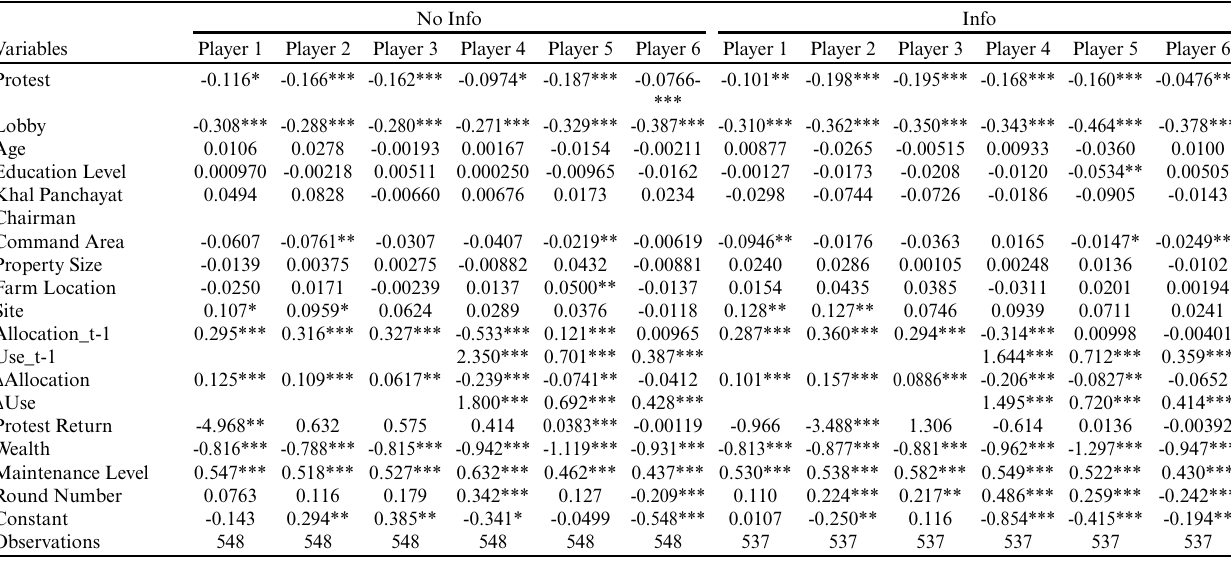
Table 6 . Player-by-player regressions: maintenance